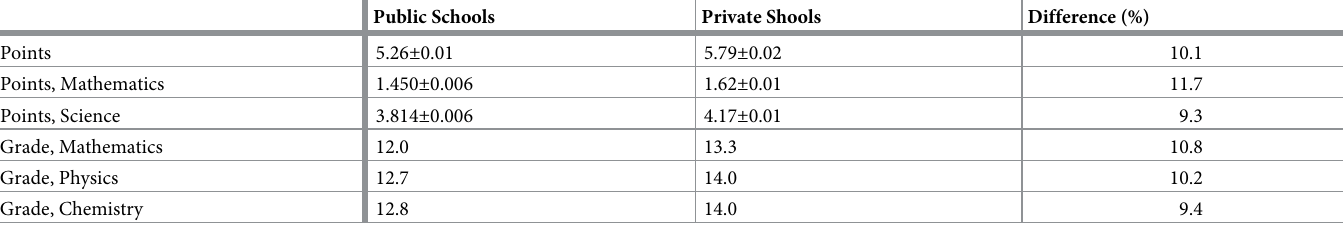
Table 1. PISA points and the average grades in mathematics, physics and chemistry of students in private and public schools in Sweden. Students in private schools have better results in PISA and also higher grades than students in public schools. These data thus suggest that there is no grade inflation at private schools in Sweden. Public